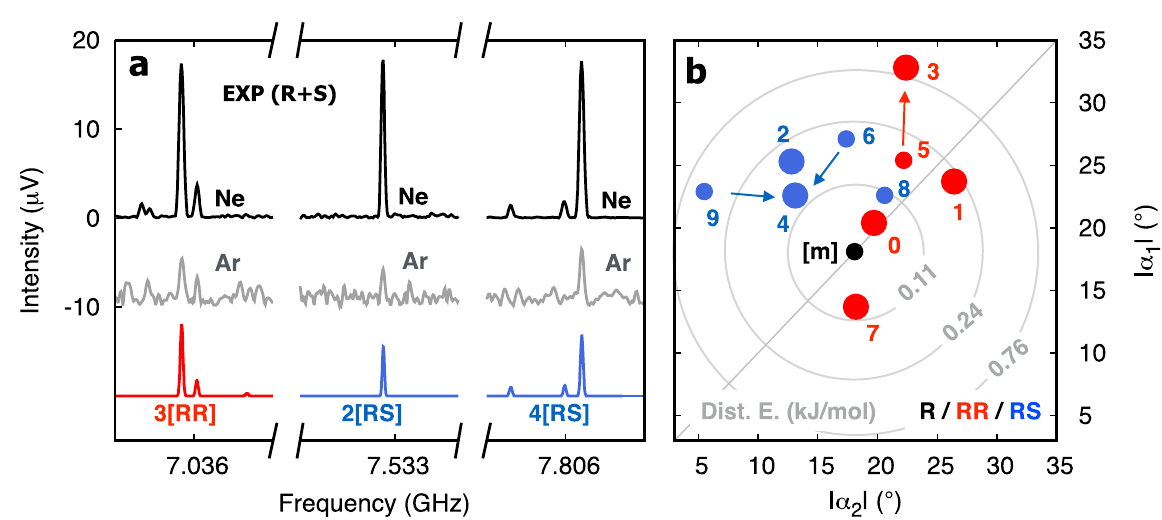
Fig. 5 Relative stabilities and distortion energies of the relevant SO dimers. a Portions of the broadband spectra using neon (black trace) and argon (grey trace) as seeding gas. The coloured traces are simulations based of the fi tted spectroscopic parameters given in Table 2. b Scatter plot depicting calculated dihedral angles ( α = C1 − C2 − C3 − O4, as in [1]RR in Fig. 1) for the SO monomer (in black), homochiral (in red) and heterochiral (in blue) dimers. The larger dots represent observed dimers. The smaller dots indicate non-observed dimers, with arrows pointing to proposed relaxation trajectories. The concentric traces indicate the energy increase due to torsion of the dihedral angle at the monomer